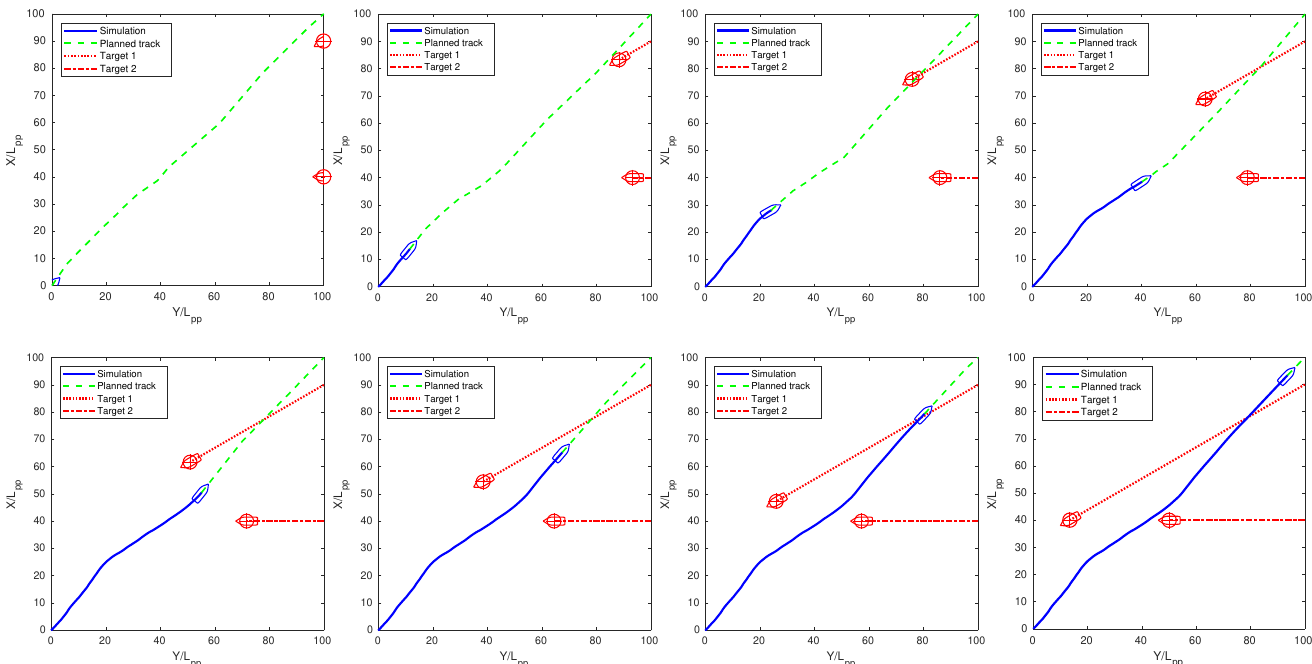
Figure 12. Scenario 2: simulation of a COLREG-non-compliant manoeuvre.